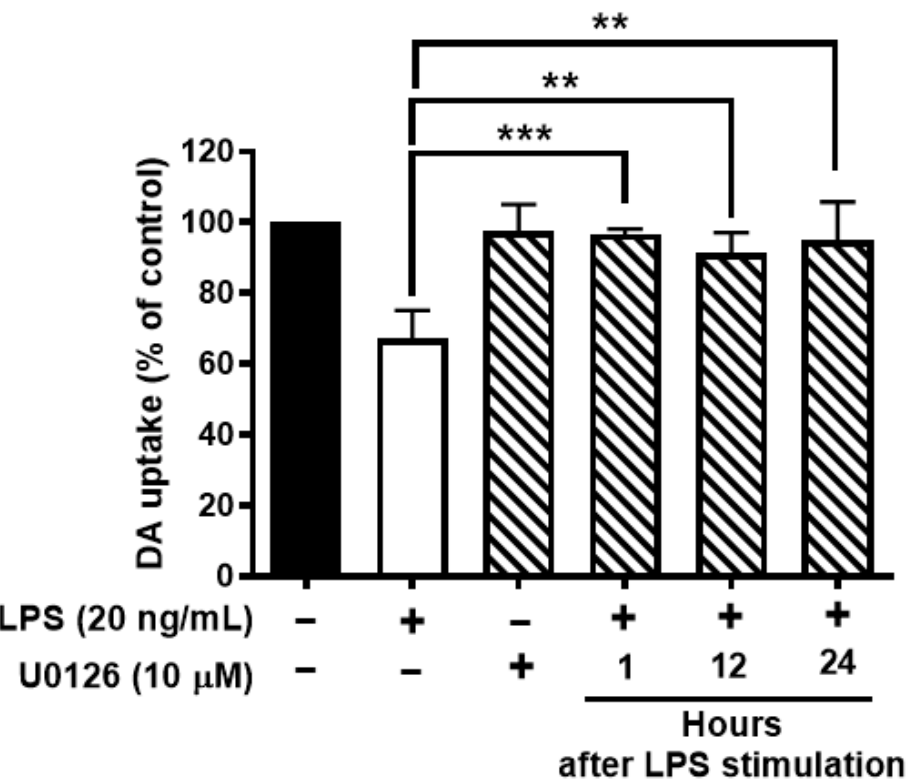
Figure 7. Inhibition of activation of ERK1/2 protects dopaminergic neurons from LPS-elicited toxicity. Wild-type neuron glial cultures were stimulated with LPS and ERK1/2 inhibitors were treated at 1, 12, or 24 h after LPS stimulation. On day 7 after LPS stimulation, cultures were subjected to DA uptake assay to detect the viability of DAergic neurons. Data show mean ± SEM from 3 independent experiments with 3 replicates per experiment. ** p < 0.01, *** p < 0.001.